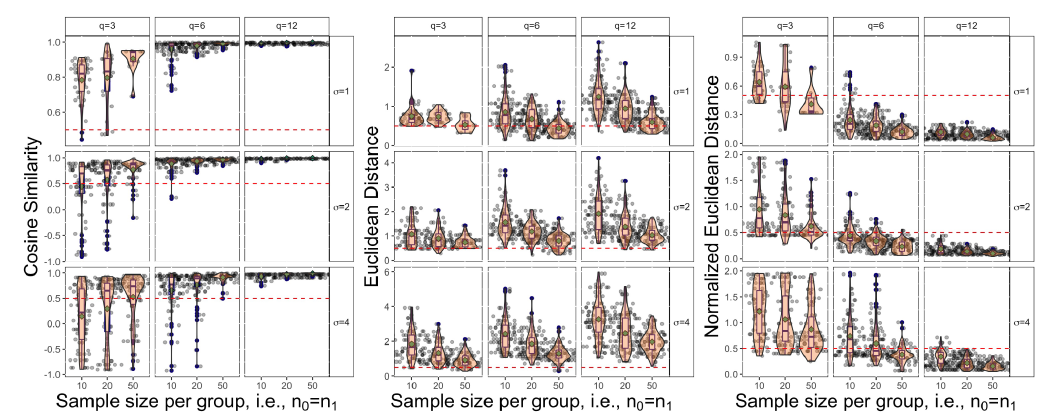
Figure 9. Estimated values of performance metrics including cosine similarity, Euclidean distance, and normalized Euclidean distance based on 100 repetitions for an L_up Hockey Stick trend with AR(1) correlation structure, ρ = 0.7, simulated across multiple settings varying repeated measurements q , sample size per group, n and σ . Note that the red dashed line serves as a reference point at 0.5 and the green dot in each panel represents the mean value across the 100 repetitions